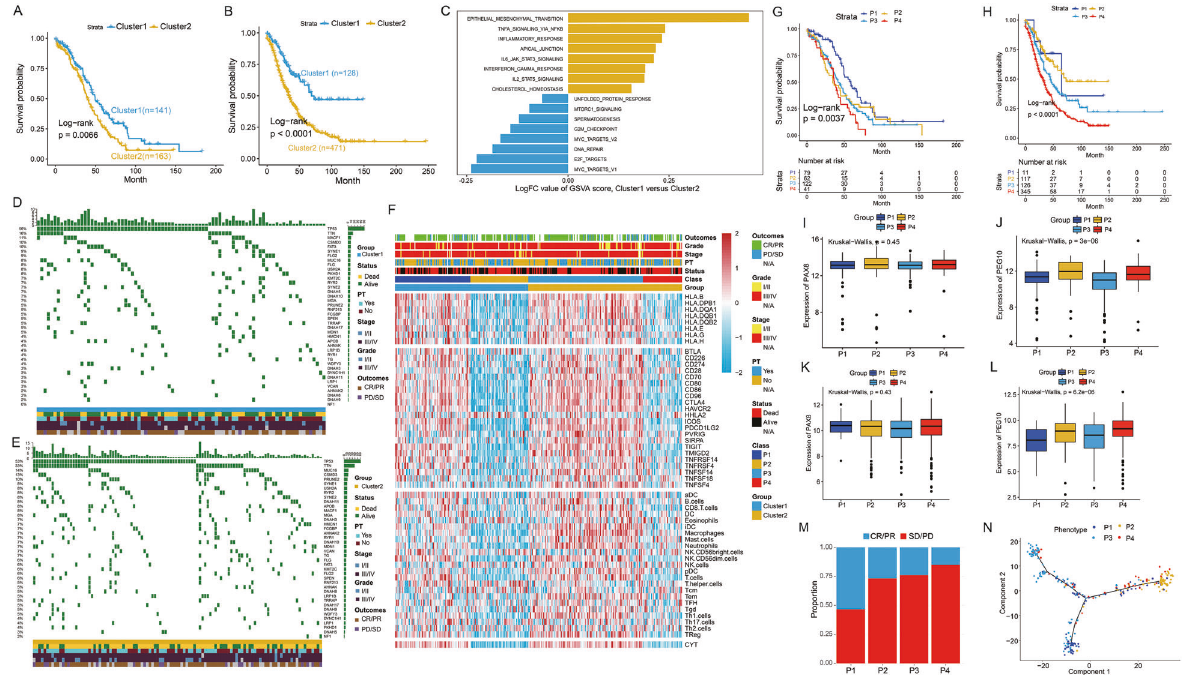
Fig. 5 Four phenotypes identi fi ed based on markers of carcinoembryonic subtype. A , B Kaplan – Meier curves for Cluster1 and Cluster2 based on TCGA OC cohort ( A ) and GEO OC meta data sets ( B ). C GSVA analysis of two clusters. D , E Waterfall chart illustration of top 40 mutated genes in the two clusters in OC. A limited number of mutations were in Cluster1 ( D ); more mutations existed in Cluster 2 ( E ). F Heatmap representation of immune molecules in four classes in TCGA OC cohort. G , H Kaplan – Meier curves for patients with four distinct phenotypes in TCGA OC cohort (Log-rank p = 0.0037, G ) and GEO OC meta data sets (Log-rank p < 0.0001, H ). I – L Boxplot illustrated the expression of PAX8 ( I , K ) and PEG10 ( J , L ) in four phenotypes based on TCGA OC cohort and GEO OC meta data sets. M Ratio of clinical response (CR/PR and PD/SD) to anti-PDL1 immunotherapy in four immune phenotypes based on IMvigor210 cohort. N Pseudotime of four phenotypes in TCGA OC cohort inferred by Monocle2. Each point corresponds to one OC sample. Phenotype information is